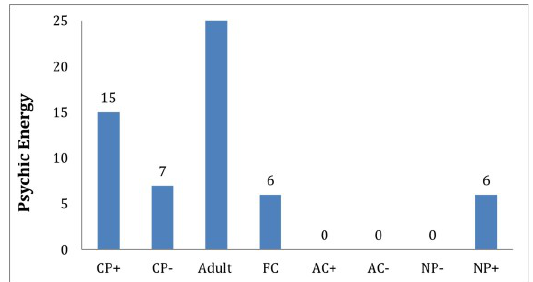
Chart 8: Egogram Teacher 4 with Student 1 In chart 8 the proportion of Adult is the highest of all the egograms. There is a similarity between the proportion NP+ in this chart and Chart 5. Also the proportion of psychic energy of FC and NP+ in this chart are the same.